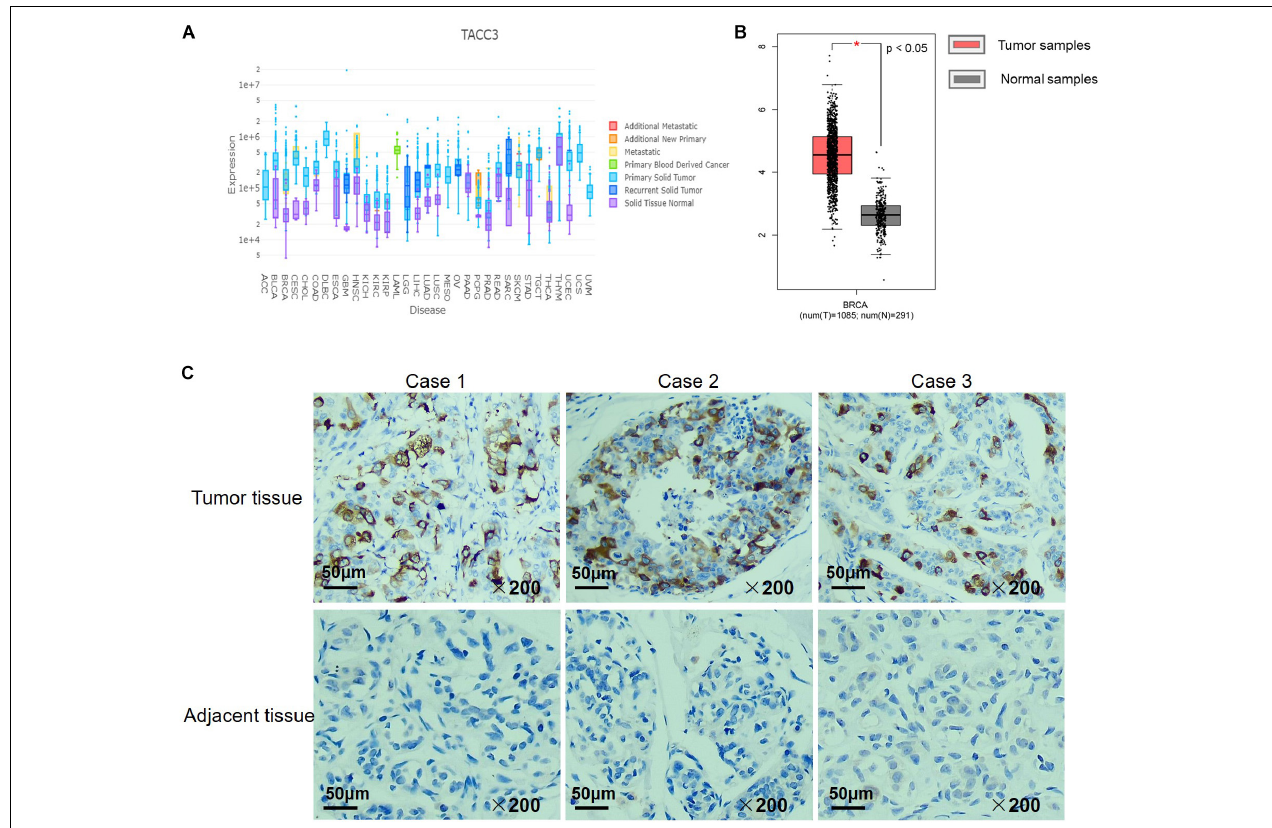
FIGURE 2 | The TACC3 expression levels in different types of cancer and normal tissues. (A) The expression levels of TACC3 expression in different tumor types using DriverDB. Red represents up-regulated genes with log2 (fold change) > 1 and green represents down-regulated genes with log2 (fold change) < –1. Blue and purple dashed lines represent the average value of all the tumor and normal tissues, respectively. (B) Gene Expression Profiling Interaction Analysis (GEPIA) for the expression of TACC3 in breast tumor tissues and normal tissues. The TCGA data revealed that TACC3 mRNA was significantly higher in breast cancer tissues (1,085 cases) than that in normal tissues (291 cases). (C) Immunohistochemical staining revealed that TACC3 exhibited high expression in breast tumor tissues. The TACC3 proteins were detected with a TACC3-specific antibody (brown), Nuclei were stained with hematoxylin (blue). Fresh breast cancer tissue specimens were obtained from 30 patients who underwent surgery. Scale bar, 50 µ